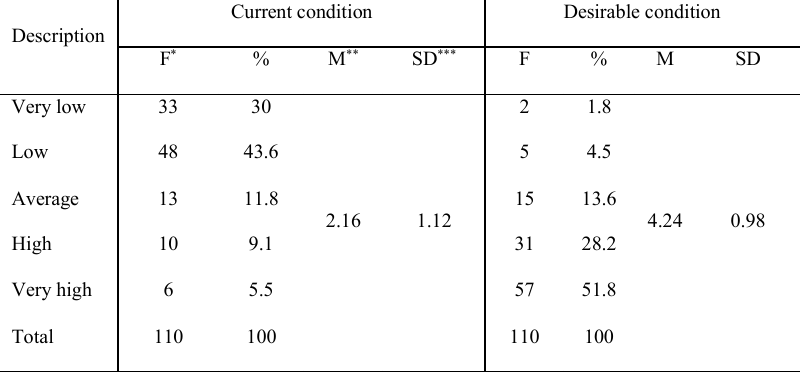
Table 7: Relative distribution of respondents according to their view of the role of the total index of economic factors in conservation and restoration of the historic textures of